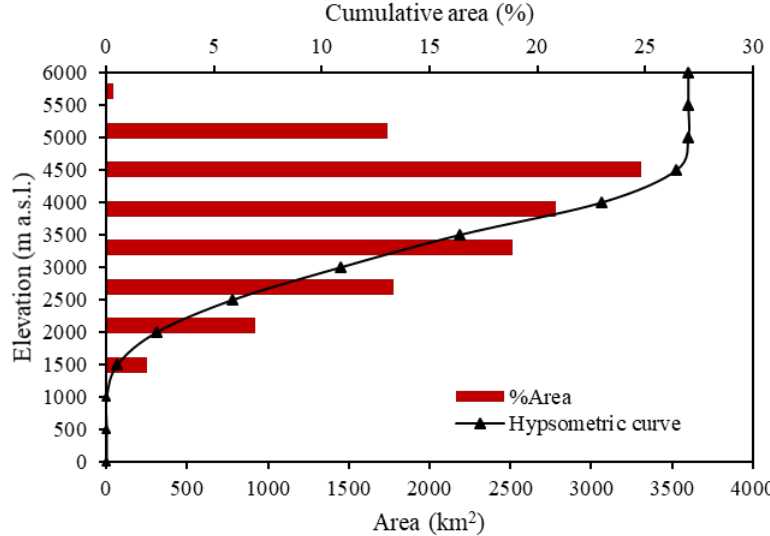
Figure 2. Hypsometric curve of the Panjshir sub-basin, estimated by using ASTER GDEM.